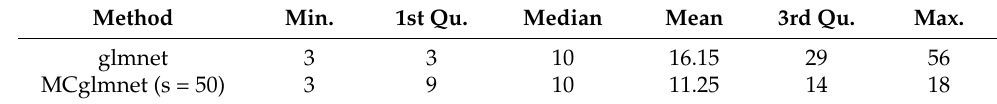
Table 2. Distribution of number of variables selected in signature. ADNI proteomics data.